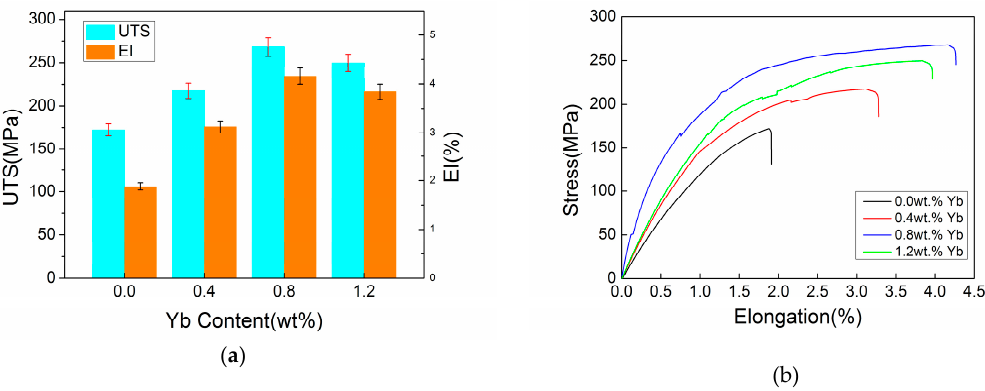
Figure 9. ( a ) Tensile strengths of as-cast ADC12 alloys with different amounts of rare earth Yb. ( b ) Stress-elongation curves of as-cast alloys with different amounts of rare earth Yb.